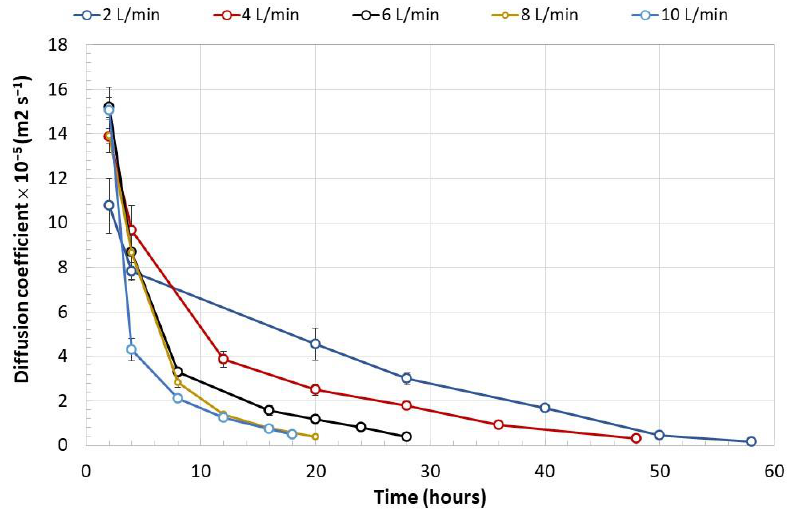
Figure 10. Diffusion coefficient (m 2 s − 1 ) of the water withdrawn from the immobilized Streptomyces mycelium under different air flows and over time. Error bars represent the standard deviation of two determinations. Two-way ANOVA (Tukey’s test for an α < 0.05). F (time) = 59.08; df = 13; p < 0.001, F (airflow) = 2.47; df = 4; p = 0.057.